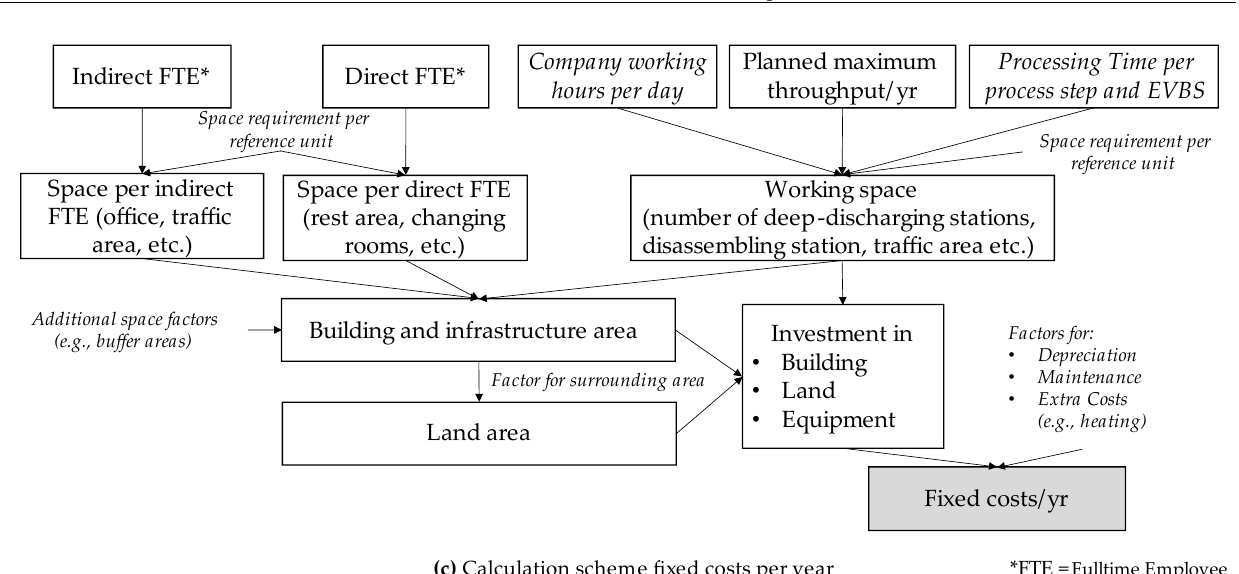
Figure 3. ( a ). Modeled process stream of the disassembly plant; ( b ) calculation scheme for variable disassembling costs; ( c ) calculation scheme annual fixed disassembling costs; explanation for ( b , c ) cursive text indicates that the factor is an external input for calculation.